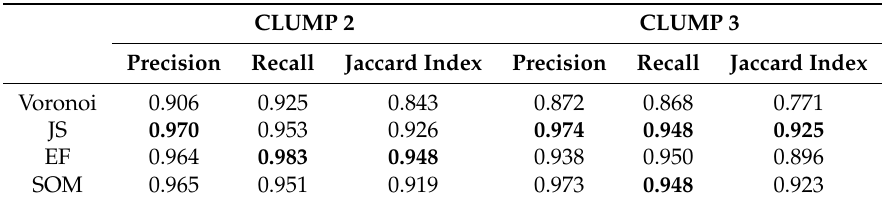
Table 2. Statistical analysis of results presented in Table 1. The Wilcoxon Signed Rank test [23] was implemented to compare the results per measurement (Voronoi, JS, EF and SOM). The table presents the p-values on the paired test for each of the pairs, (first and second columns). Tests where the null hypothesis could not be rejected are highlighted.